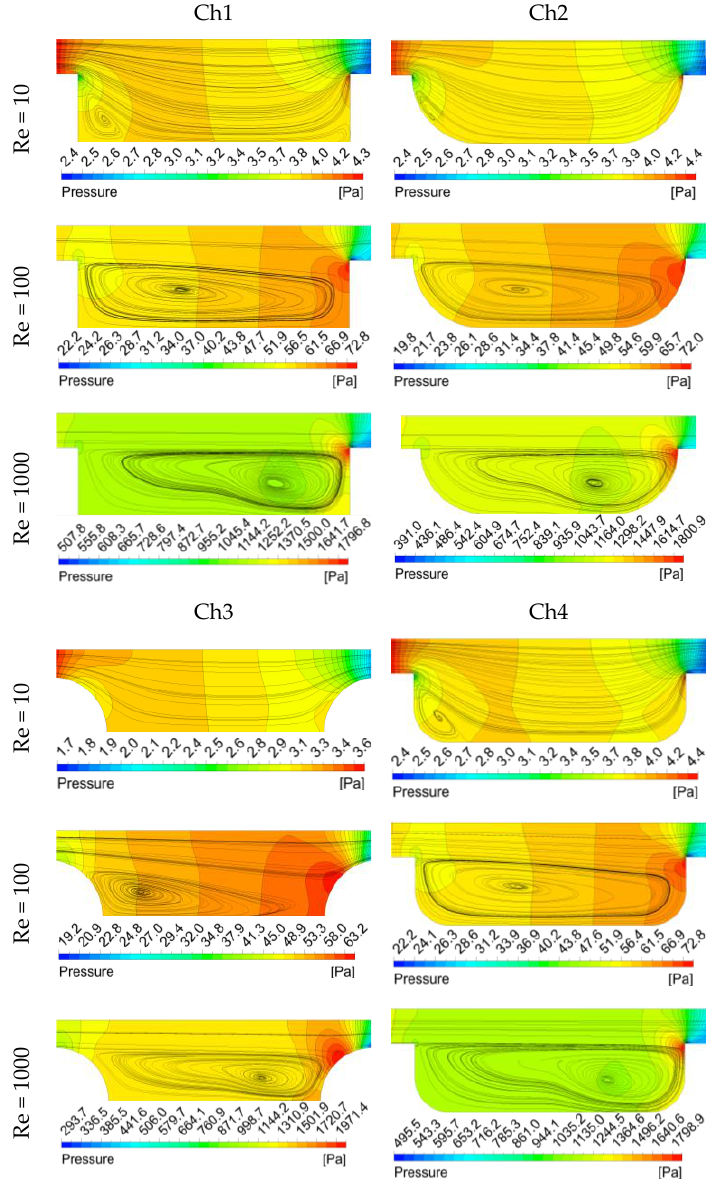
Figure 6. Static pressure contours and velocity streamlines in Ch1, Ch2 and Ch3 at Re = 10, 100 and 1000.